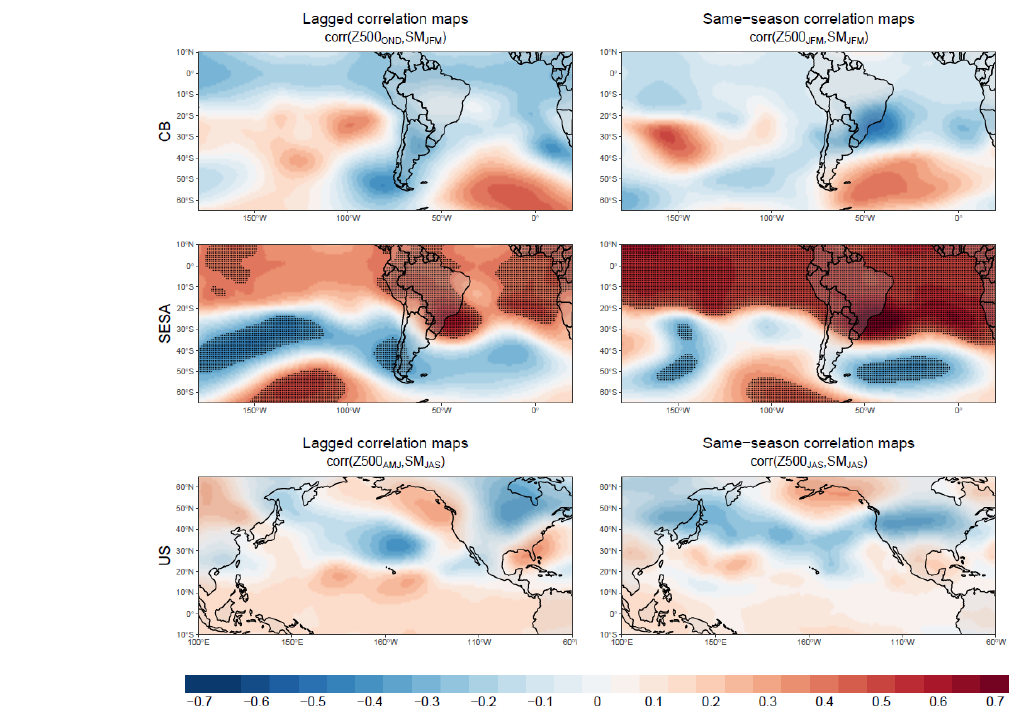
Figure A2. Correlation maps at both lagged and same-season time steps for Z500 variable against summer soil moisture. Stippling indicates statistical significance ( P FDR < 0 . 1) after having corrected for false-discovery rate using the Benjamini–Hochberg correction.